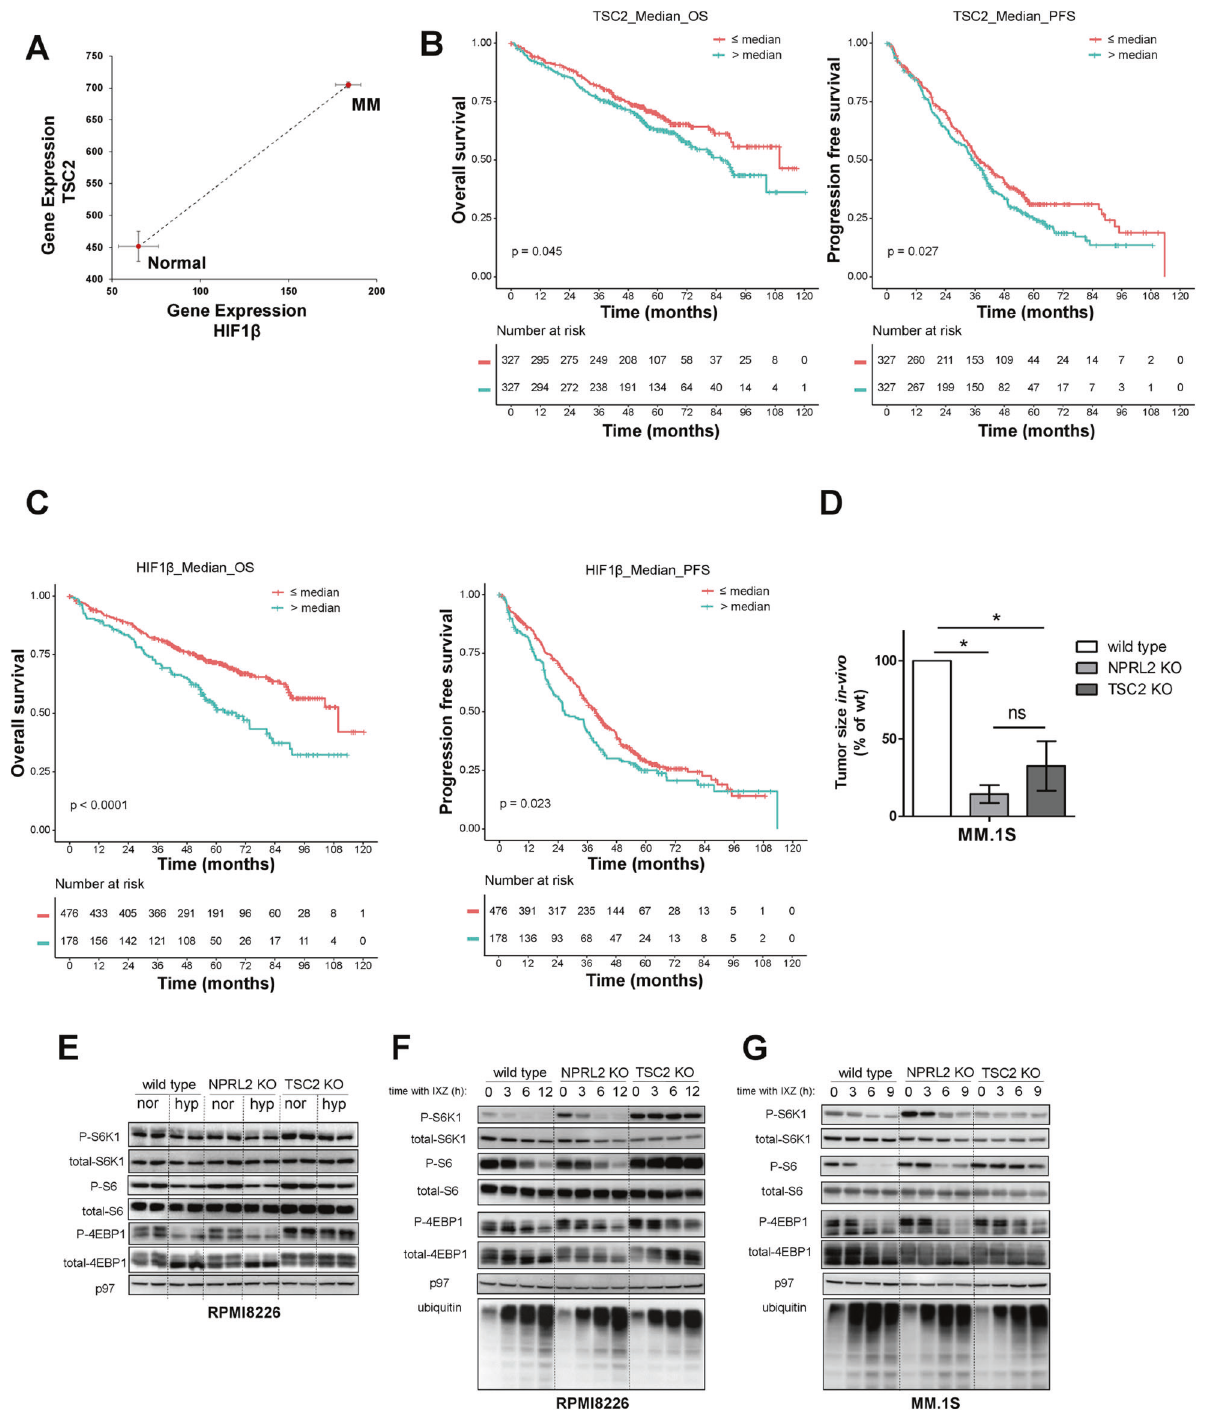
Fig. 1 Hypoxia and proteasomal inhibition independently cause mTORC1 suppression in MM. A A relative correlation between mRNA expression level of TSC2 and HIF1 β in CD138 + bone marrow plasma cells from healthy subjects (n = 22) and newly diagnosed MM patients ( n = 559). Axis units are arbitrary. Error bars represent S.E.M. B , C Shown are Kaplan – Meier plots for the overall survival (OS) and progression- free survival (PFS) of MM patients with differential expression of TSC2 ( B ) and HIF1 β ( C ) from GMMG HD4 and MM5 trials. D Subcutaneous tumor growth of wt, NPRL2 KO, and TSC2 KO MM.1S cells into NCG mice ( n = 4). Shown is the average relative tumor weight ± S.E.M. and the asterisk represents p < 0.05 of unpaired two-tailed student ’ s t -test between wt and KO. ns, not signi fi cant. E Cells were cultured in fresh media for 4 h in either normoxia or hypoxia. mTORC1 response was assessed by immunoblotting of its downstream phosphorylated and total effectors, S6K1, S6, and 4E-BP1. p97 was used to con fi rm equal protein loading in each lane. Shown are technical duplicates in each condition of a typical experiment of three repetitions. F , G Cells were cultured in fresh media for 16 h, then treated with IXZ [32 nM]. Following the treatment, cells were collected for immunoblotting in increasing time points as indicated. Shown are immunoblots for downstream effectors of mTORC1. Ubiquitin immunoblot was used to assess proteasomal inhibition. Shown are a typical immunoblots out of three independent experiments. nor, normoxia. hyp, hypoxia, IXZ, ixazomib. Cell Death and Disease (2022)